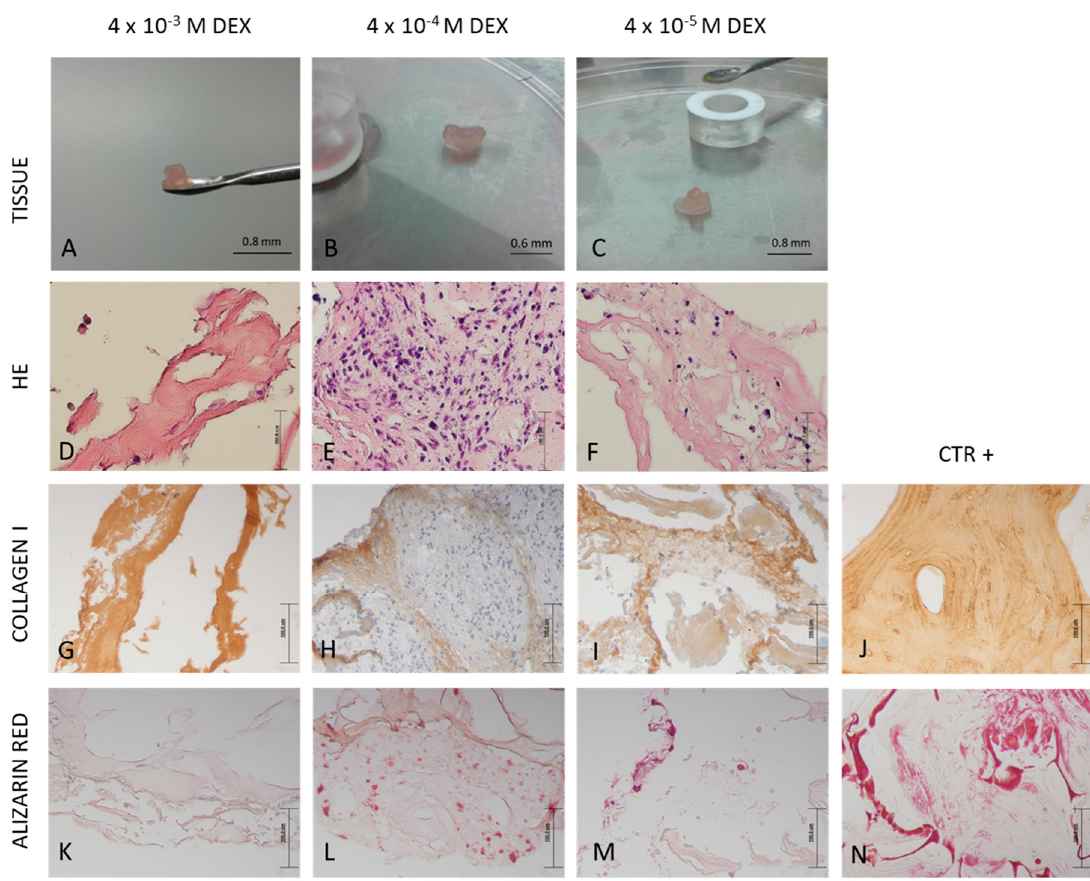
Figure 3. Macroscopic appearance and histology of in vitro engineered bone tissue in a three-dimensional perfusion bioreactor culture. RADA 16-I scaffolds were mixed with different concentrations of DEX: 4 × 10 − 3 , 4 × 10 − 4 and 4 × 10 − 5 M, seeded with human mesenchymal stem cells (hMSC) and cultured for 21 days in a perfusion bioreactor system. Macroscopic appearance: ( A – C) . Scale bar represents 0.8 and 0.6 mm. Histology appearance: ( D – F ) hematoxylin-eosin (HE) staining; ( G – J) collagen type I immunohistochemistry staining; ( K – N ) Alizarin Red staining. Scale bar represents 100 µ m. Positive control for immunohistochemistry staining is human bone. Positive control for Alizarin Red staining are hMSCs differentiated on the 30% hydroxyapatite scaffold for 21 days in a perfusion bioreactor.